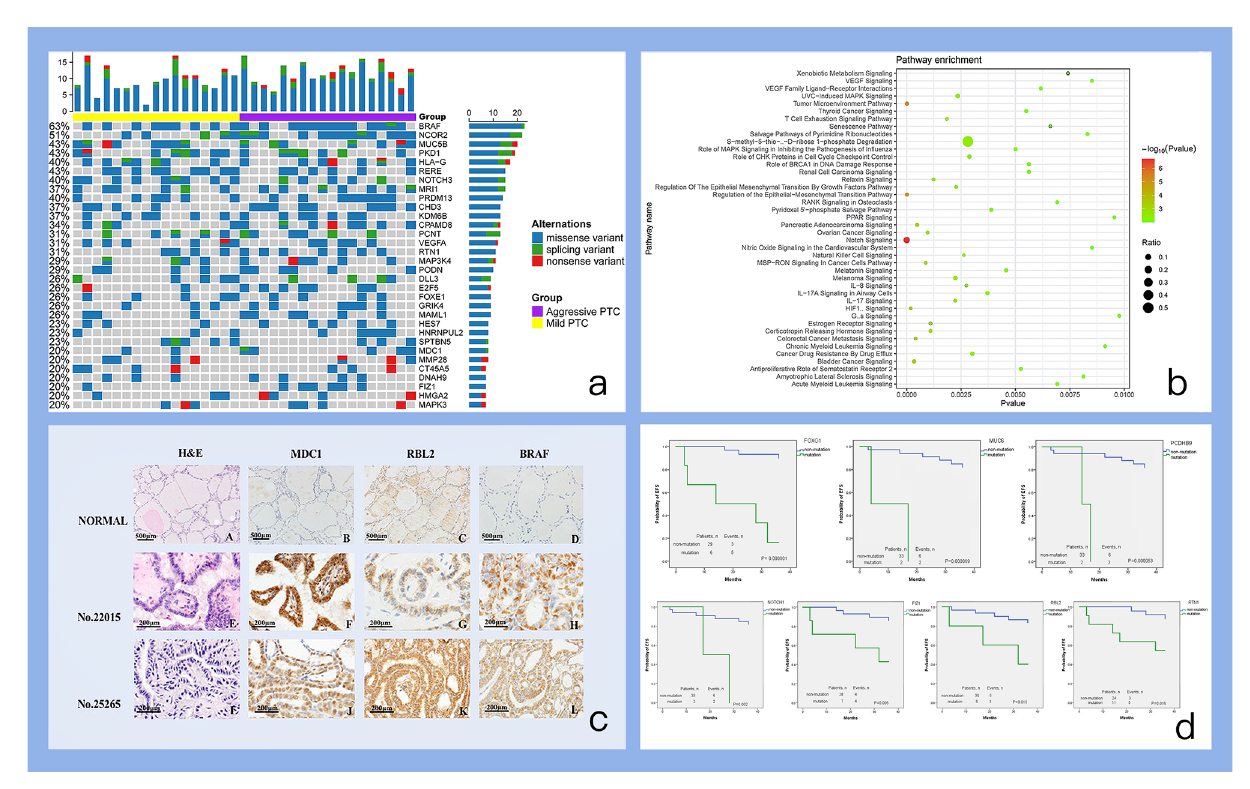
FIGURE 3 | Figures of important fi ndings. (a) Mutation pro fi le of high-frequency somatic mutant genes. Each row represents a somatic mutant gene, and each column represents one individual. The bar on each row indicates the mutation number (mutation frequency) of one gene occurring on all individuals. The bar on each column indicates the number of mutated genes for one individual. (b) Pathway enrichments of high-frequency somatic mutant genes. The pathways enriched with high-frequency somatic mutant genes are evaluated and identi fi ed by IPA tool. (c) IHC results of candidate mutant genes. A-D. Normal thyroid tissue with HE, MDC1, RBL2, BRAF IHC staining. E-H. PTC tumor sample (No.22015) from patients con fi rmed recurrence with HE, MDC1, RBL2, BRAF IHC staining. I-L PTC tumor sample (No.25265) from patients without con fi rmed recurrence with HE, MDC1, RBL2, BRAF IHC staining). (d) Survival analysis of selected candidate mutant genes. Each subplot displays the survival plot of one mutant gene